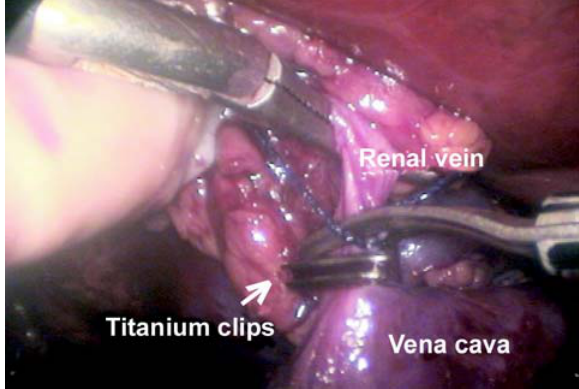
Figure 7 – The Satinsky clamp is placed on the vena cava and the renal vein is divided with a cuff of the vena